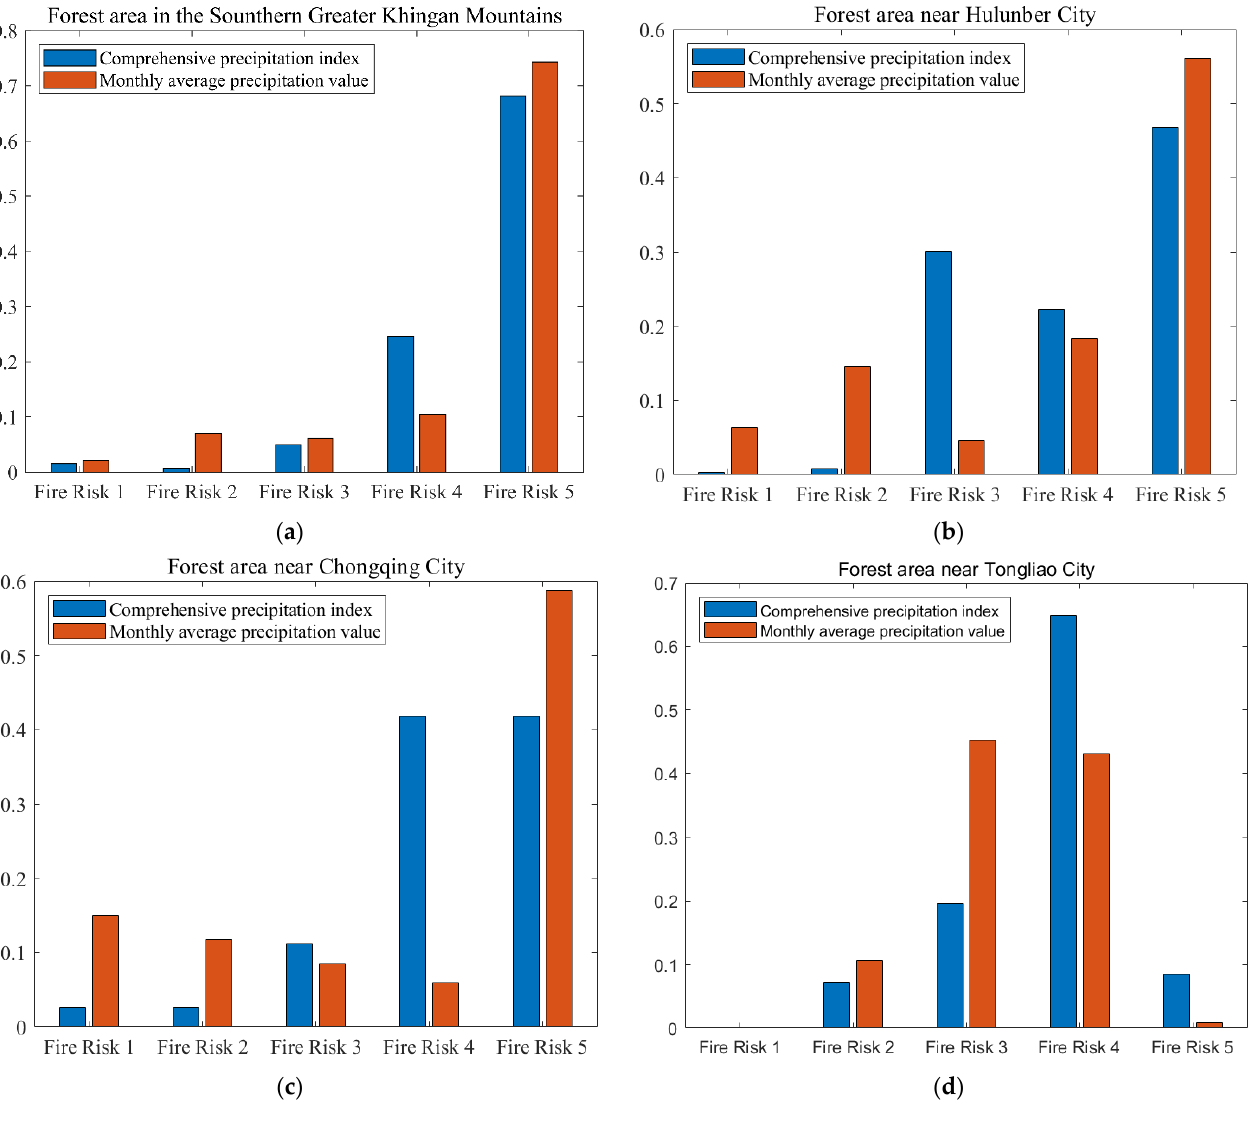
Figure 6. Proportion of fire points that fall within the forest fire danger rating map in four different forest areas in the test set trained by the two different methods: ( a ) forest area in the southern part of Greater Khingan Mountains; ( b ) forest area near Hulunber city; ( c ) forest area near Chongqing city; ( d ) forest area near Tongliao city.